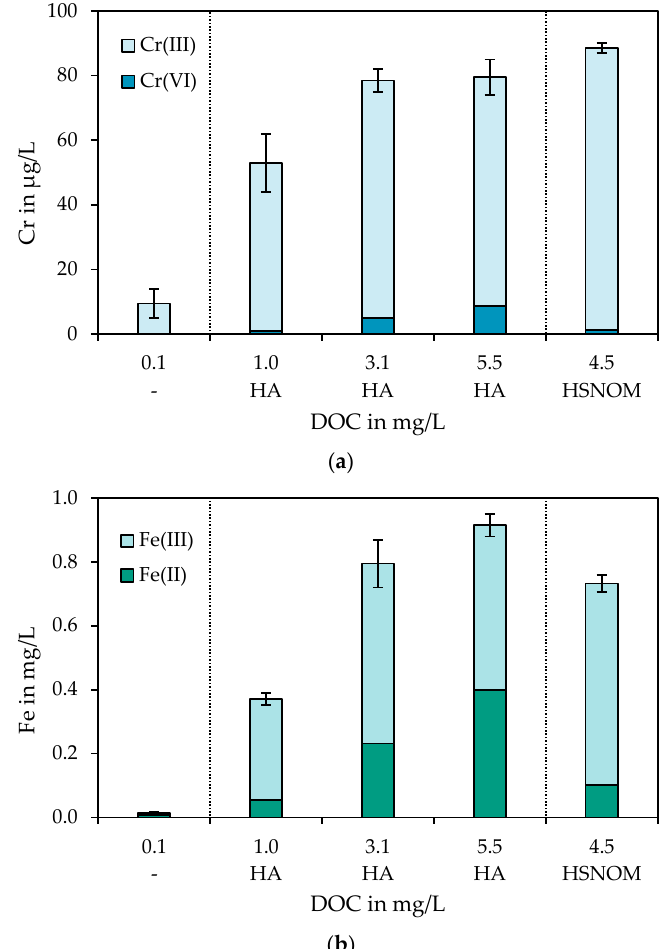
Figure 2. Mean residual concentrations of ( a ) Cr(VI) and Cr(III), and ( b ) Fe(II) and Fe(III), at increasing initial DOC concentrations of terrestrial humic acid (HA) and natural aquatic NOM from “Hohlohsee” (HSNOM). Test conditions: 100 µg/L Cr(VI), 1.0 mg/L Fe(II), pH 7.5, t = 60 min, n = 2; error bars indicate minimum and maximum.